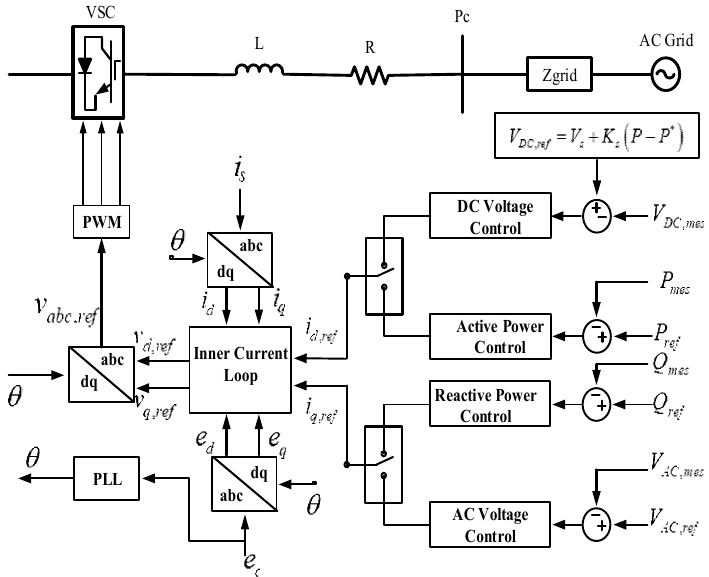
Figure 2. The d–q control architecture of solid state transformers-voltage source converters (SST- VSC).